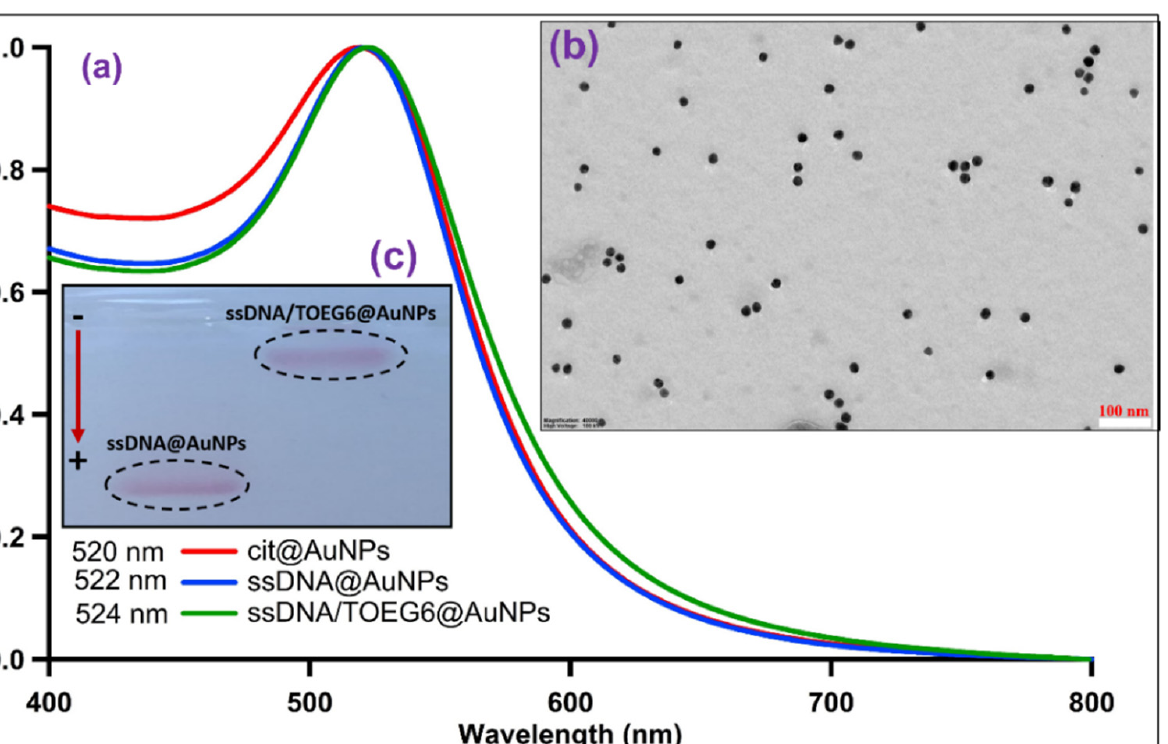
Figure 2 . ( A,B ) A TEM micrograph of synthesized AuNPs with a scale bar of 100 nm, and the statis- tical analysis indicating nanoparticle size distribution evaluated for over 250 nanoparticles. ( C,D ) A 2×2 µm 2 AFM non-contact mode image of AuNPs deposited on poly-L-ornithine-coated mica, and its corresponding statistical analysis.